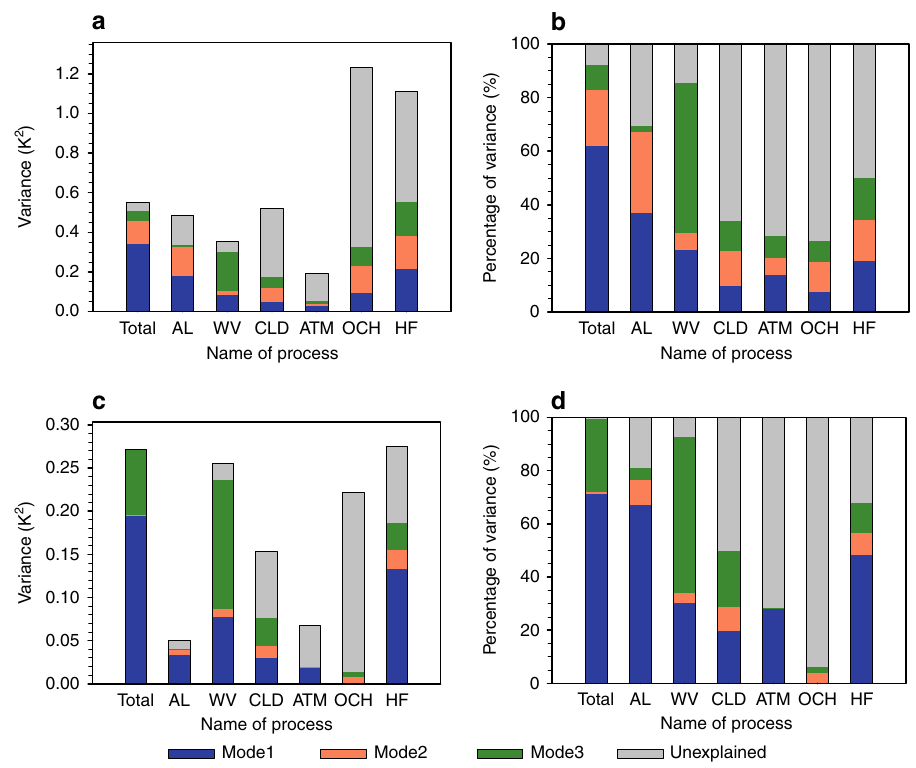
Fig. 4 Variances of warming pattern spread (WPS) and global warming spread (GWS) explained by the three most dominant modes. a The variance ( K 2 ) of the zonal mean fi elds of the inter-model spread in total surface temperature change and the individual partial surface temperature changes. The color portions of each bar represent the variance explained by the fi rst three EOFs (empirical orthogonal function), while the gray portion is the remaining variance. b The percentage (%) of the variance explained by the fi rst three EOF modes (colors) and the remaining unexplained percentage by the three modes is in gray. c , d Same as a and b but for the variance of GWS. The abbreviations AL, WV, CLD, ATM, OCN, and HF stand for processes of ice-albedo, water vapor, clouds, atmospheric dynamics, ocean dynamics plus heat storage, and surface turbulent heat fl uxes,